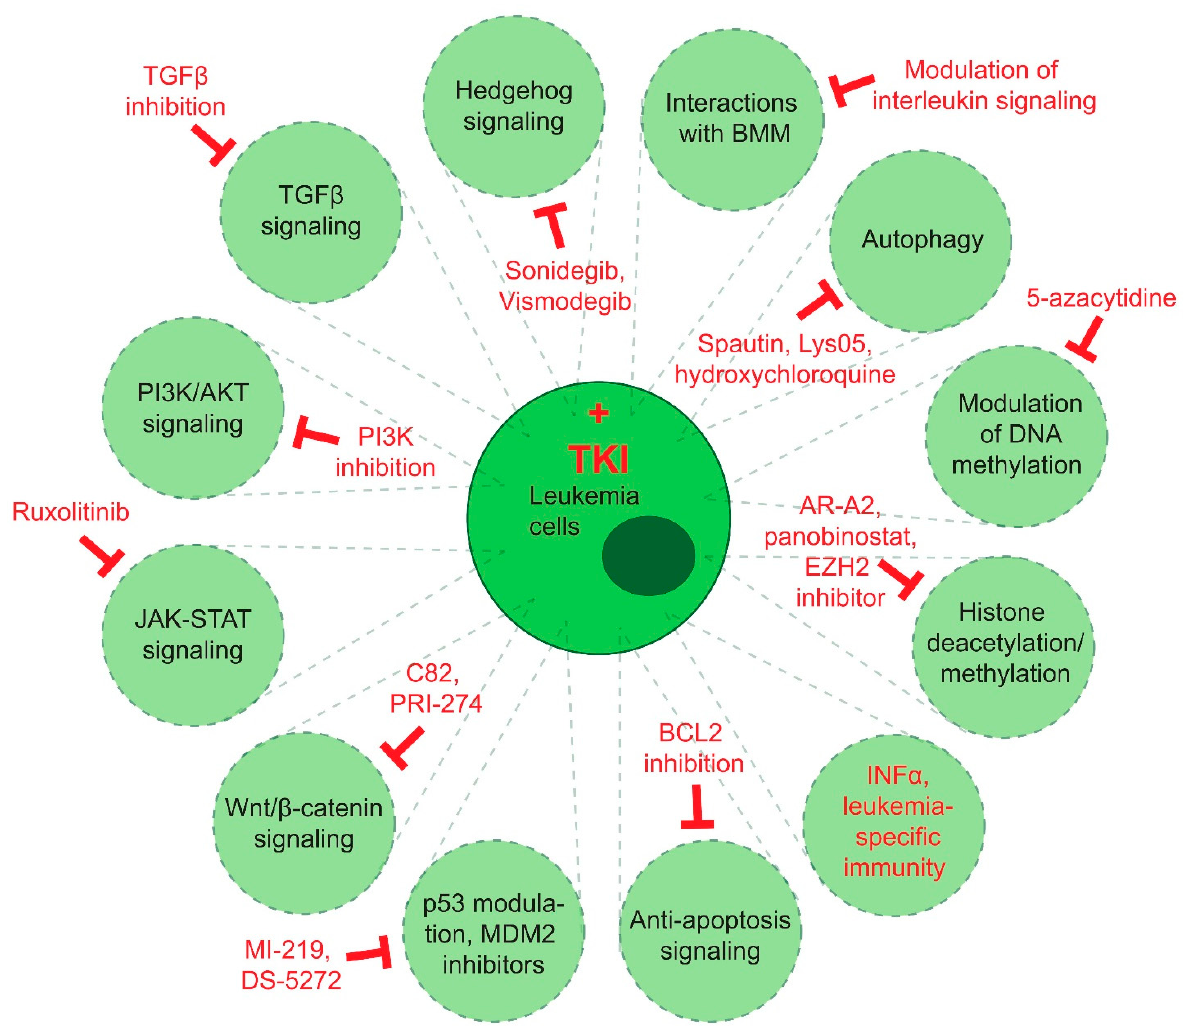
Figure 3. Strategies for targeting CML stem cells (in red) with tyrosine kinase inhibitors (TKIs) and other agents in combination therapies. TGF 𝛽 1 = transforming growth factor 𝛽 1; EZH2 = Enhancer of zeste homolog 2; BCL-2 = B-cell lymphoma 2 ; PI3K/AKT = phosphoinositide 3-kinase/AKT Serine/Threonine Kinase 1; IFN 𝛼 = interferon 𝛼 ; MDM2 = MDM2 proto-oncogene; JAK-STAT = Janus kinase ( JAK )-signal transducer and activator of transcription.